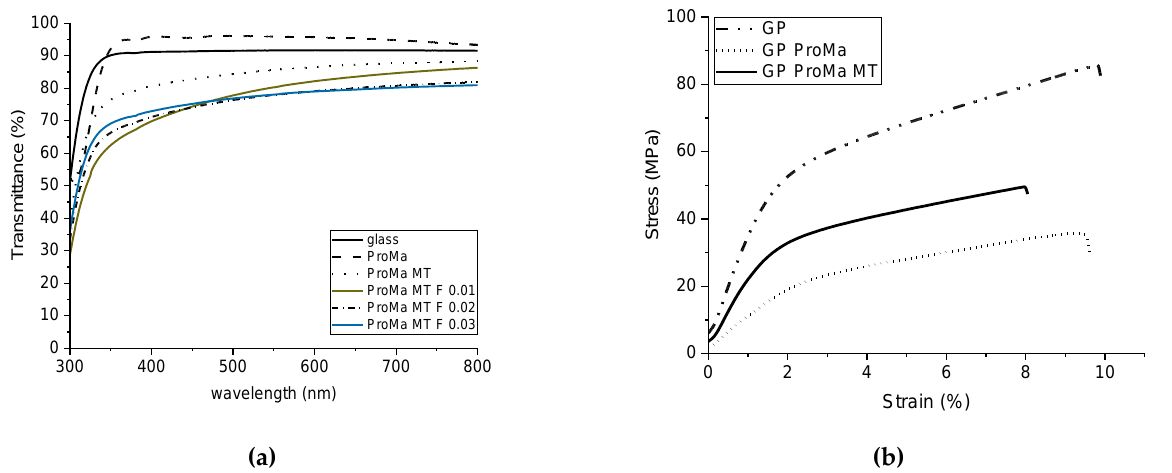
Figure 6. ( a ) UV light transmission of glass and the coatings ProMa, ProMa MT, ProMa MT F (0.01; 0.02; 0.03) on glass. ( b ) Stress (mPa) plotted against the strain (%) of glassine paper and glassine paper coated with ProMa and ProMa MT.